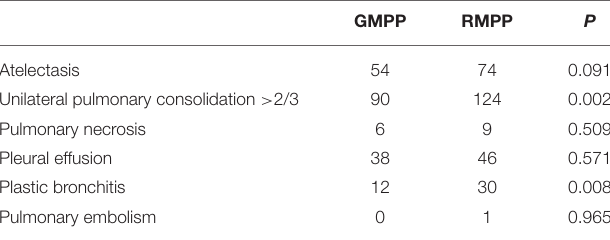
TABLE 3 | Radiological data and fiberoptic bronchoscopy data of GMPP and RMPP patients.